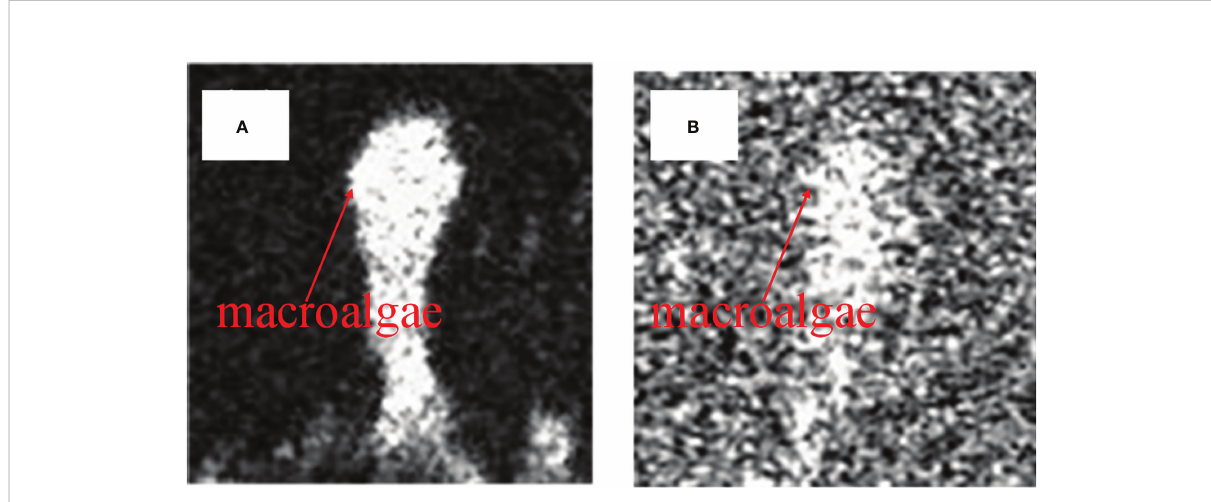
FIGURE 2 Comparison of visual interpretation quality of the fl oating macroalgae in two polarization modes of Sentinel-1: (A) VV; (B)